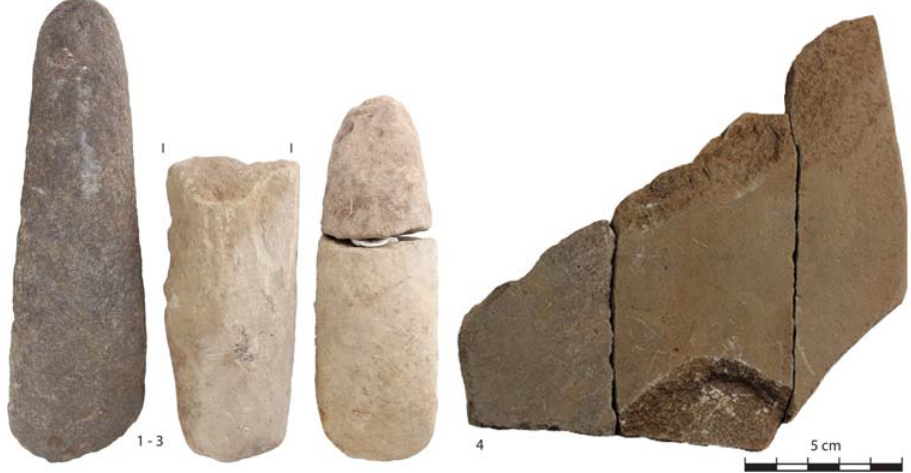
Figure 10: Typical rock adzes and a sandstone grinding slab re fi tted from several fragments ( no. 1 − 3. Adal; 4. Løvås ) .